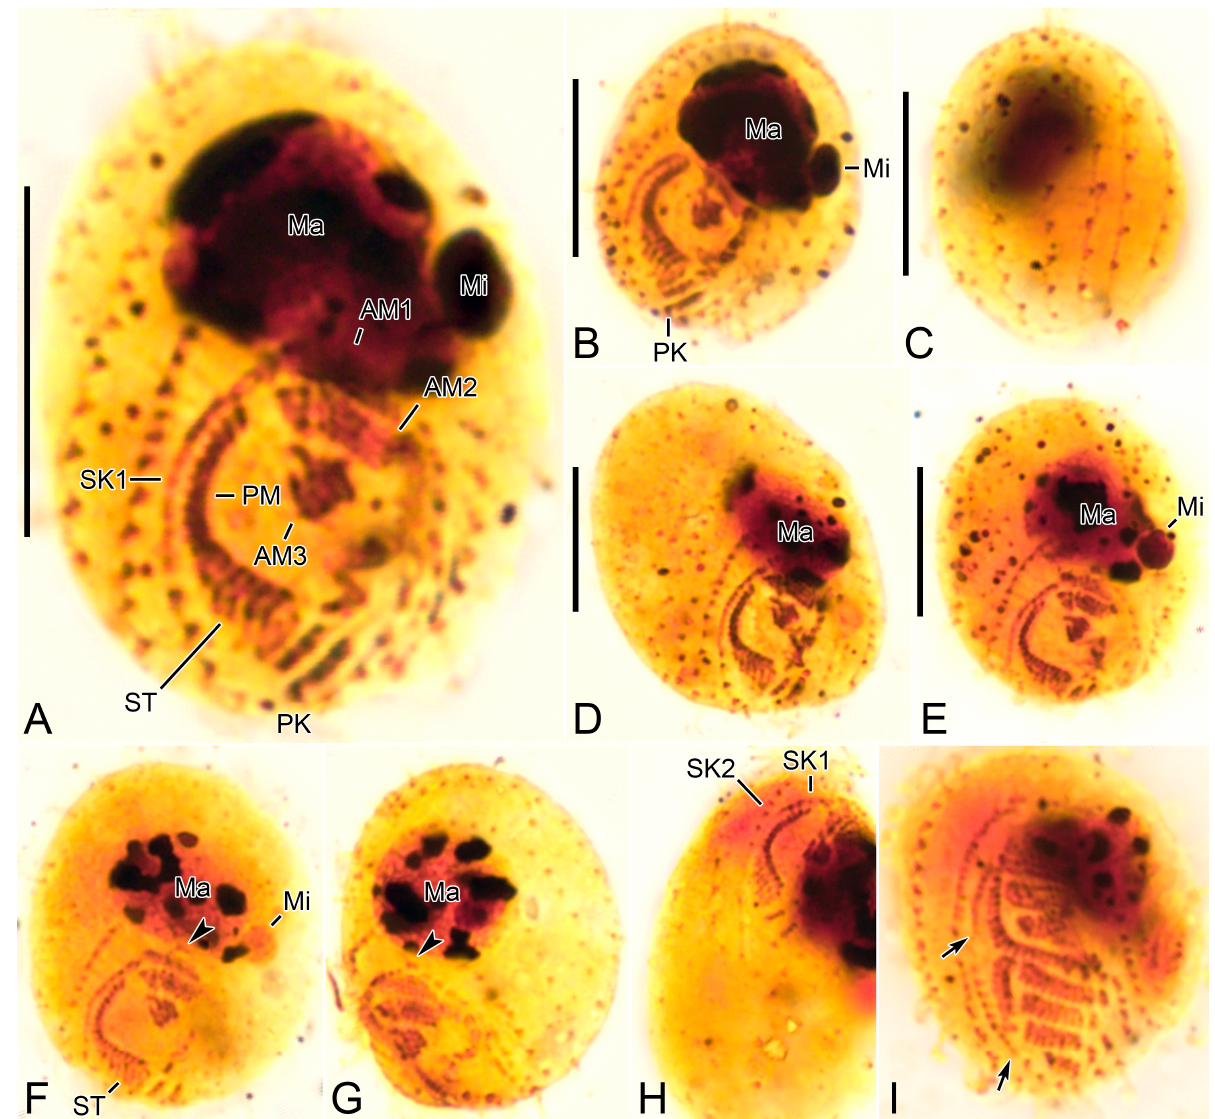
Figure 6. Cinetochilides minimus sp. nov. after silver carbonate impregnation. ( A – H ). Ventral ( A , B , D – H ) and dorsal ( C ) view showing the ciliatures and nuclear apparatus. The fragmented somatic kinety 1 is connected by kinetodesmata. Note that these specimens were flattened by a coverslip, so that they lost the typical body shape and appeared to be larger than other cells. Arrowheads ( F , G ) denote the dikinetids in somatic kinety n-1. ( I ). Ventral view of mid-divider. The basal bodies of scutica (arrows) are arranged in a row between the paroral membrane and somatic kinety 1. AM, adoral membranelles; Ma, macronuclear nodules; Mi, micronuclei; PM, paroral membrane; PK, postoral kineties; SK, somatic kineties; ST, scutica. Scale bars: 10 µm.